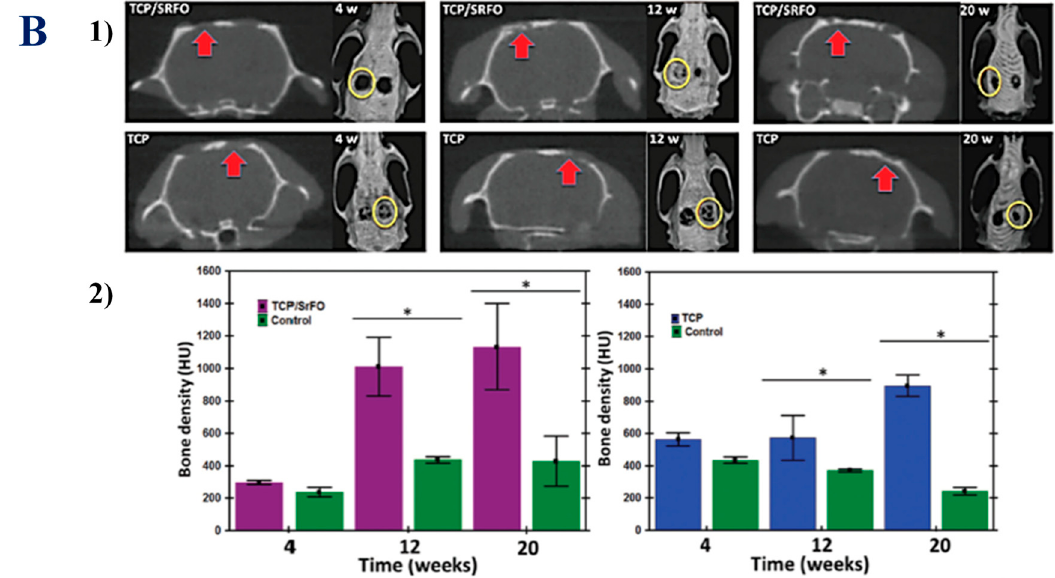
Figure 2. B-vitamins in bone repair. ( A ) Schematic diagram showing the different options to promote bone regeneration processes. Up-arrows mean enhanced. Down-arrows mean decreased. ( B ) Micro-computed tomography images of cranial defects treated with TCP and TCP/SrFO scaffolds at 4, 12 and 20 weeks and defect closure on the side of the implants form the coronal plane (arrows) and 3D images (circles) ( 1 ) and bone density of the radiographic density (HU) in cranial defects ( 2 ) (* p < 0.001). Figure 2B is reproduced from [16] with permission from the Royal Society of Chemistry.